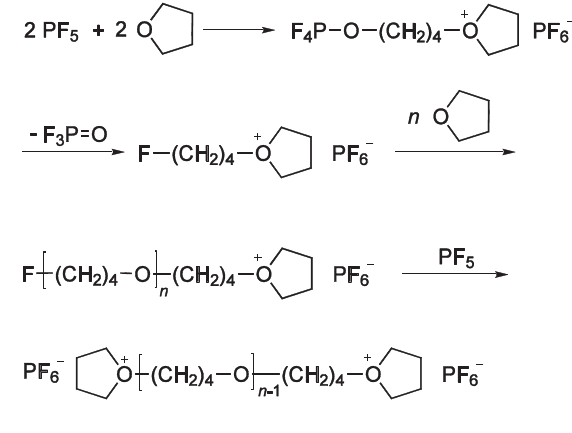
. Chain growth from both chain 5